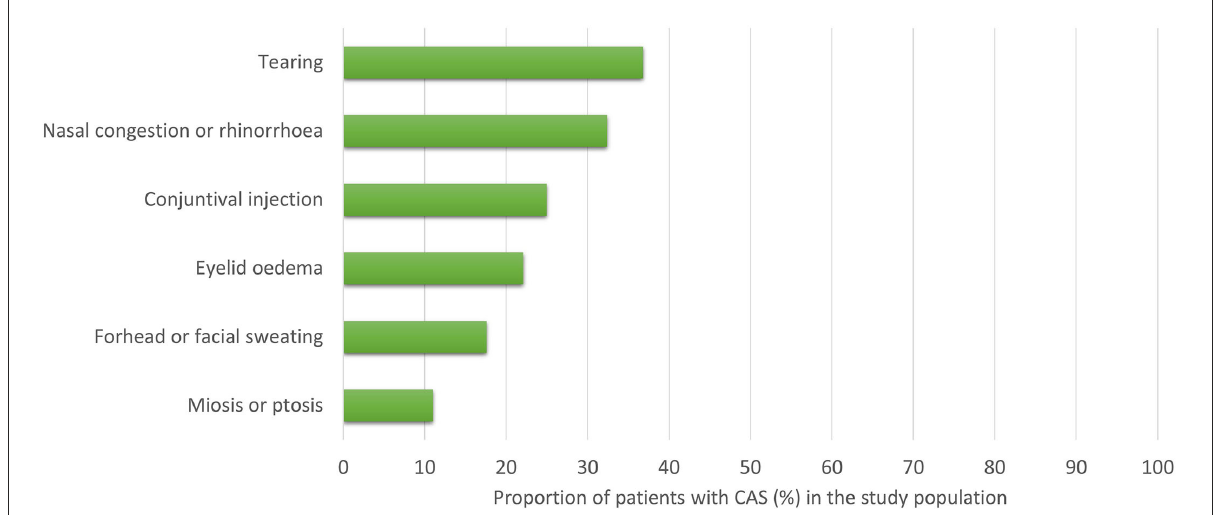
FIGURE2 Frequency of cranial autonomic symptoms ( N = 88). CAS, Cranial Autonomic Symptoms.